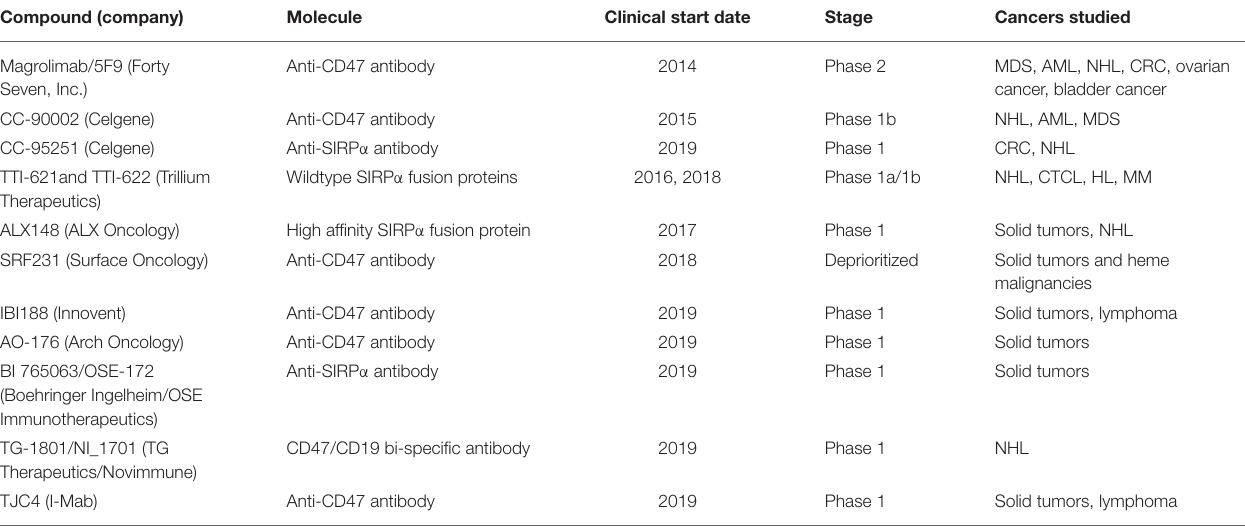
TABLE 1 | CD47/SIRP α targeting agents in clinical development in the US. Compound (company) Molecule Magrolimab/5F9 (Forty Seven,